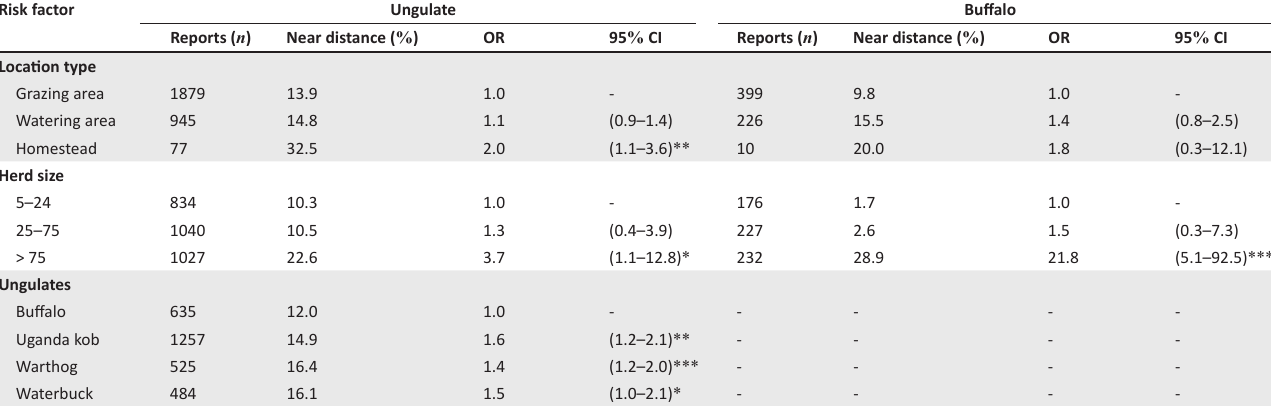
TABLE 6: Risk factors associated with distance (near vs. far) of cattle from wildlife reported for ungulates and buffalo including odds ratios for univariate mixed models with farmer as a random effect. Risk factor